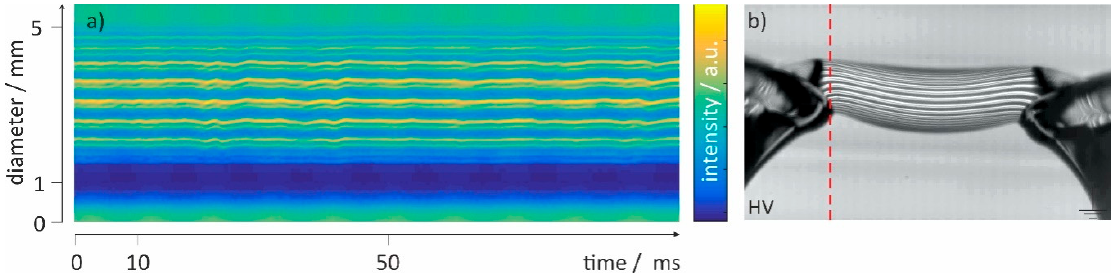
Figure 6. Time–space plot ( a ) from a water bridge, ( b ) run at 19kV and 0.8mA, bridge temperature ~39 °C at the horizontal position indicated with a red, dashed line. In ( a ) highly irregular structures appear as spikes in the otherwise horizontal fringes.